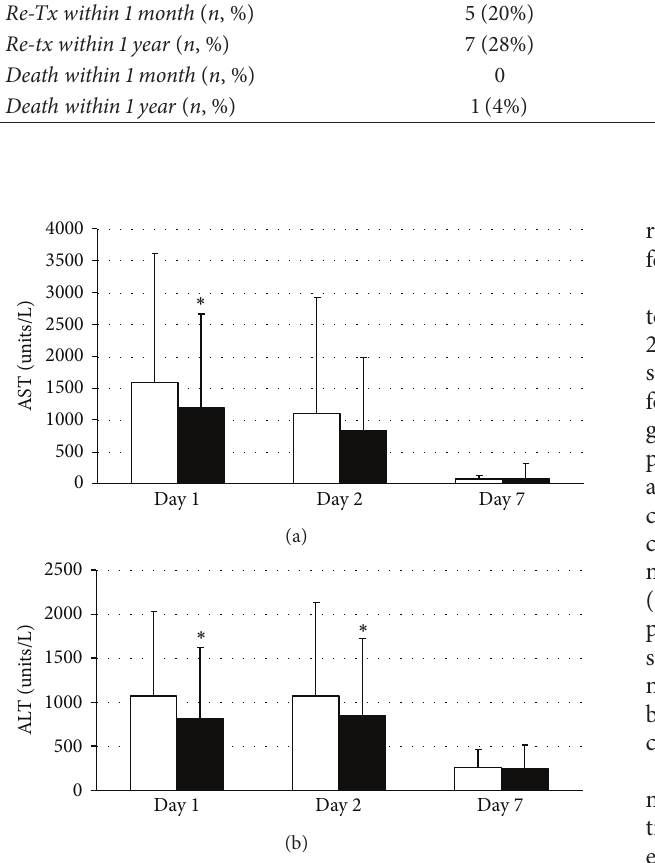
Figure 1: Serum transaminases in the first week after transplanta- tion in patients with low (group L, white bar) and high pretransplant bilirubin(groupH,blackbar);(a)aspartateaminotransferase(AST); (b) alanine aminotransferase (ALT); ∗ 𝑝 < 0.05